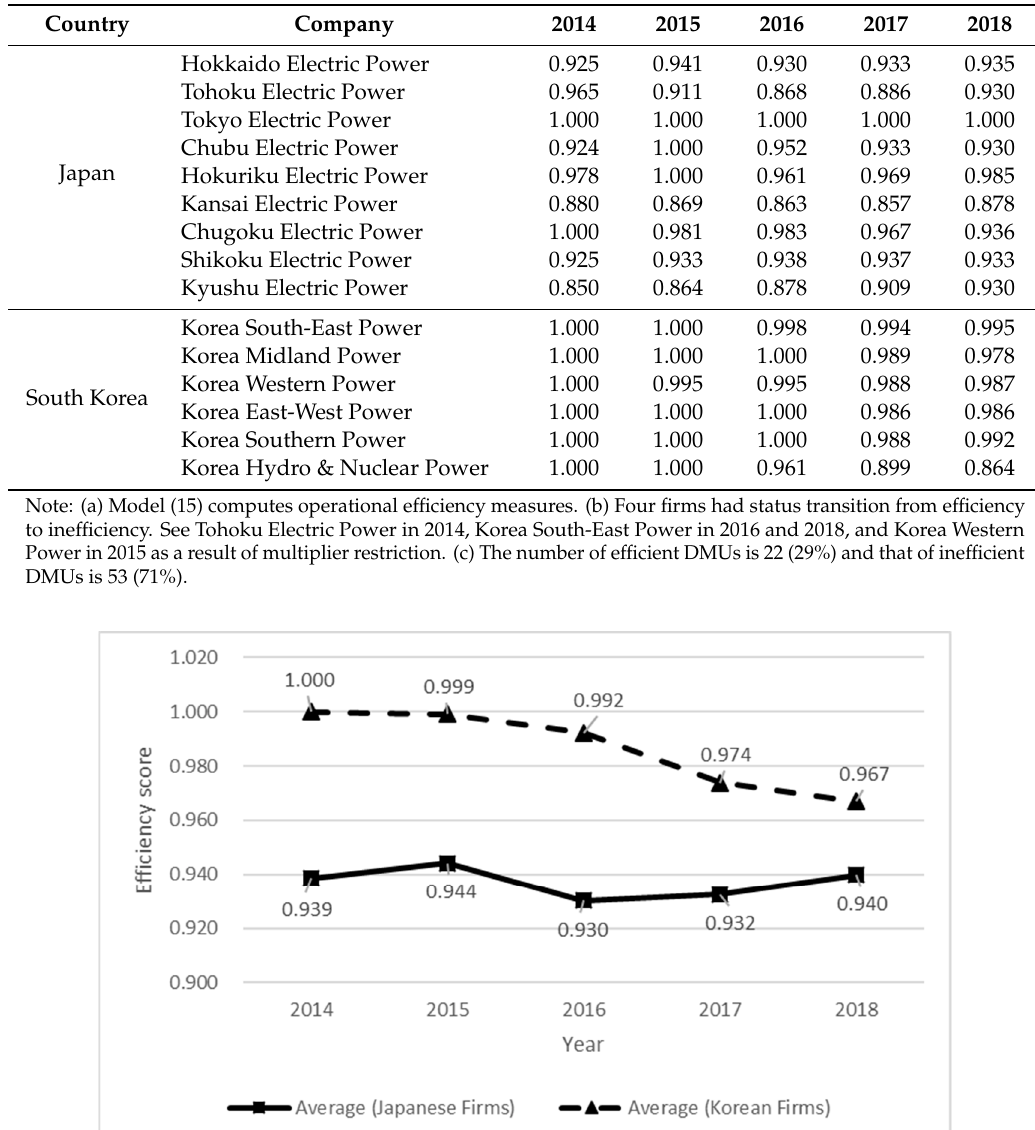
Table 7. E ffi ciencies of Japanese and Korean Power Companies with Multiplier Restriction.